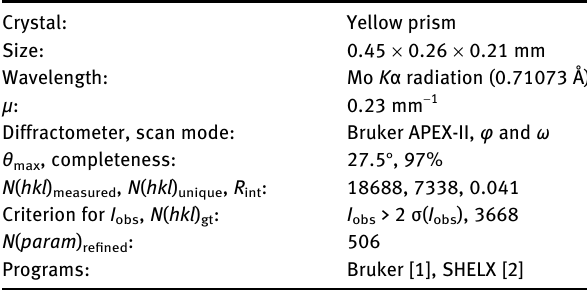
Table  : Data collection and